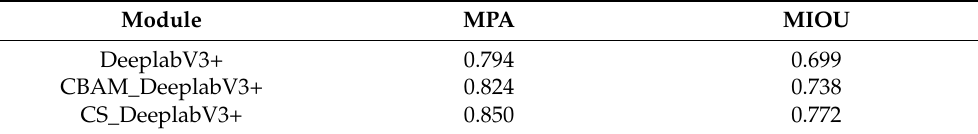
Table 1. The network performance comparison of each module.